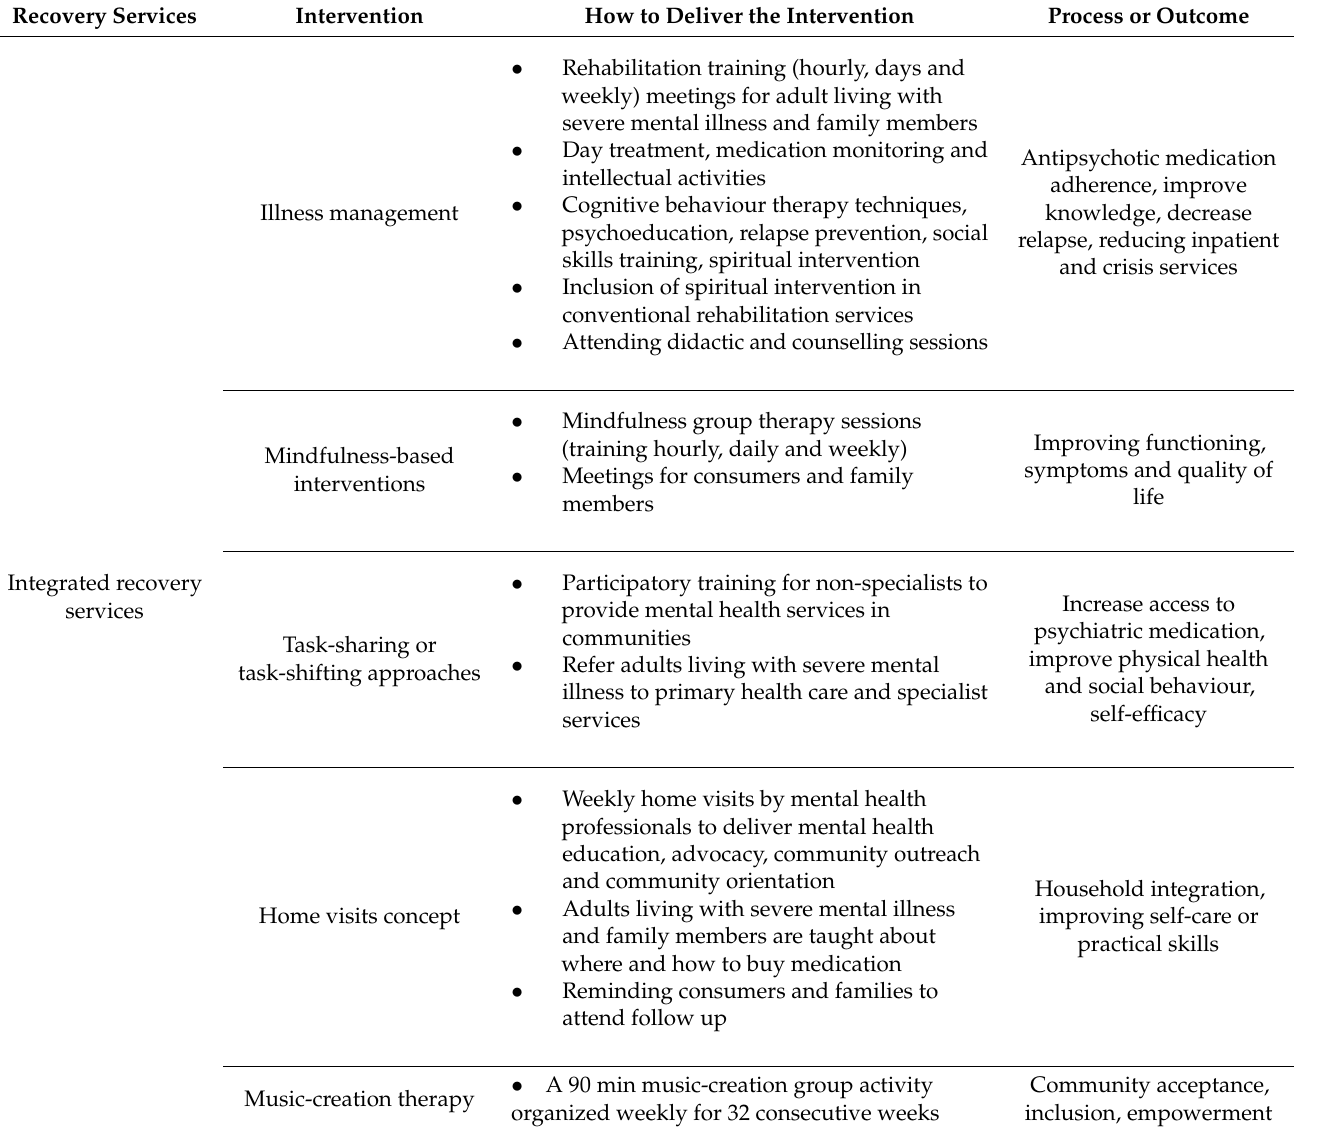
Table 4. Mechanisms for implementing recovery